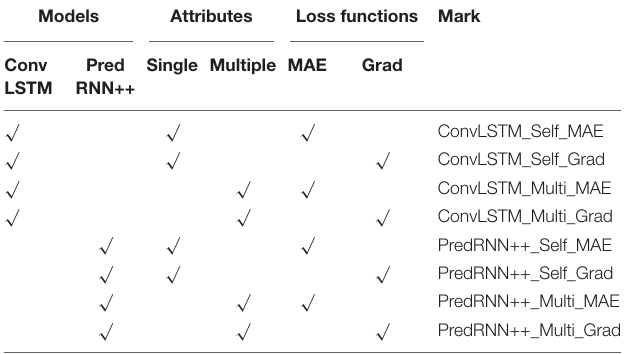
TABLE 2 | SIC prediction model comparison experiment design.